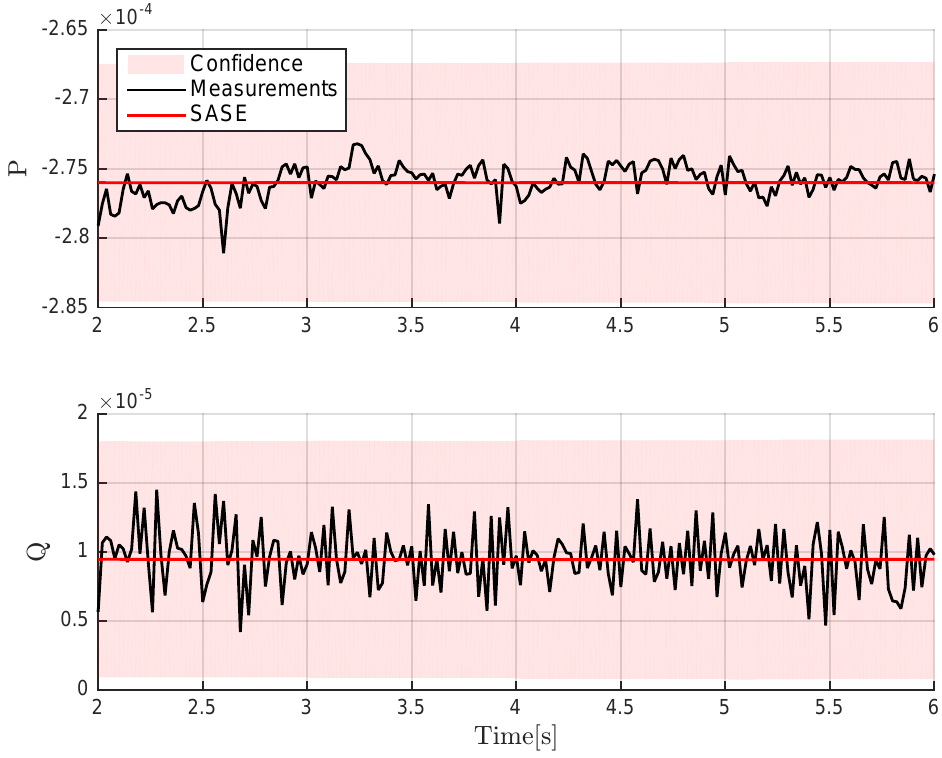
Figure 8. Detail: Evolution of the estimates (excluding [12]) at node 5 (used for validation) using three PMUs for estimation and two for validation. Table 2. Total vector error (TVE) for estimation and prediction of SASE and the algorithm [12] in the time interval [ 2,6 ] s, using 3 PMUs for